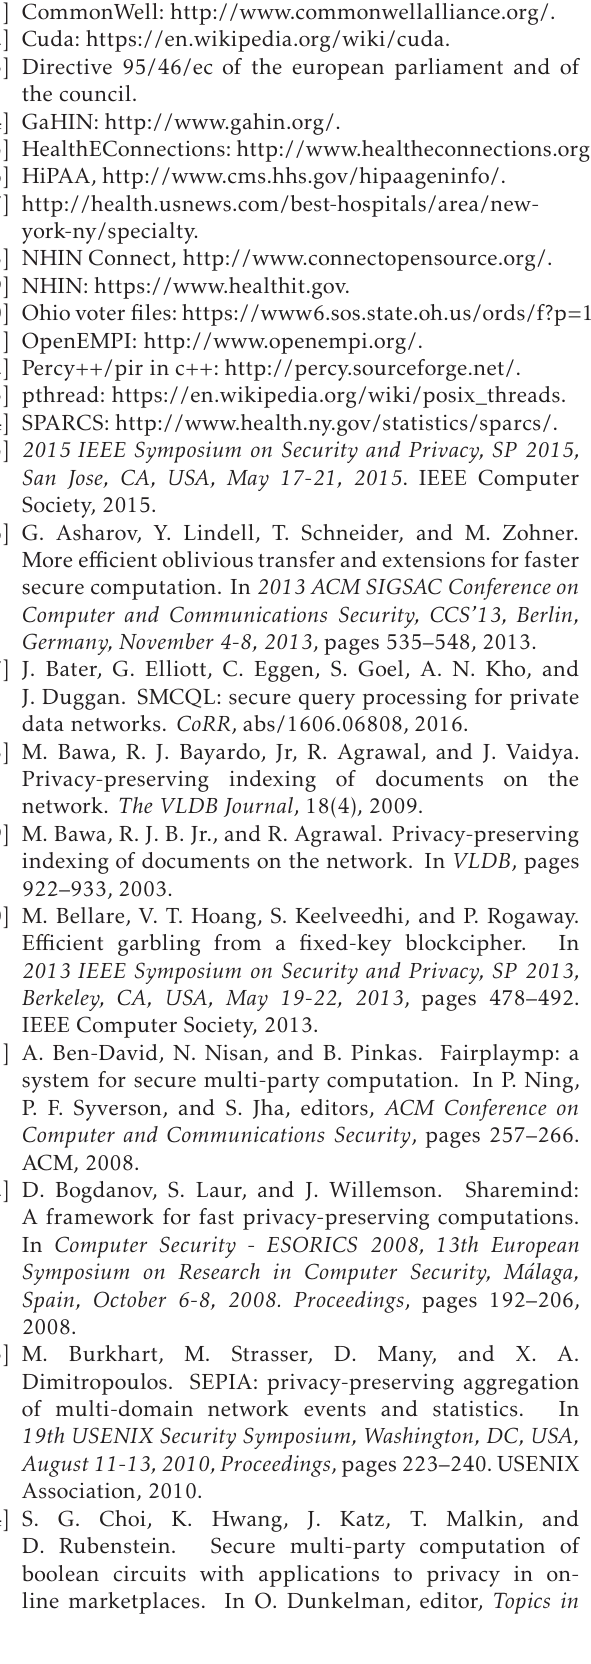
E ffi cient garbling from a fixed-key